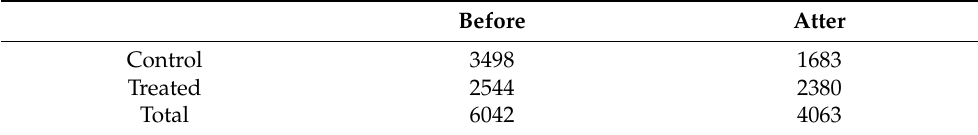
Table 5. Changes in the sample size before and after PSM.